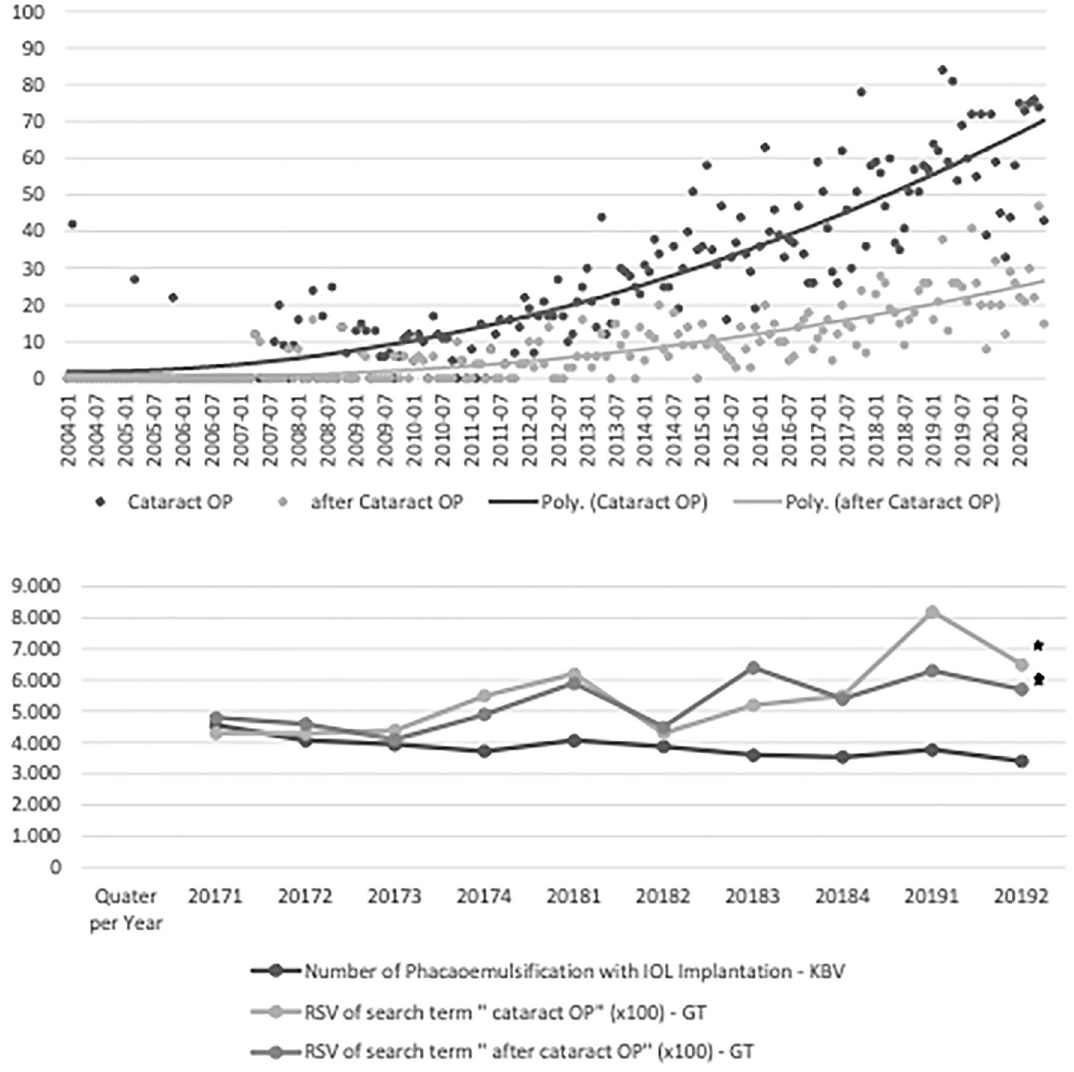
Figure 2. Above) Relative Search Volume (RSV) over time of search terms concerning cataract surgery from 2004 till 2020 in Germany. X-Axis Time (Month/Year), Y-Axis RSV Range 0–100. Below) Correlation between search queries concerning cataract surgery (RSV) and number of cataract surgeries in Germany between March 2017 and June 2019. X-Axis: Time (Year/Quarter), Y-Axis: RSV × 100, Number of cataract surgeries performed. RSV (relative search volume). Star shows statistically significant